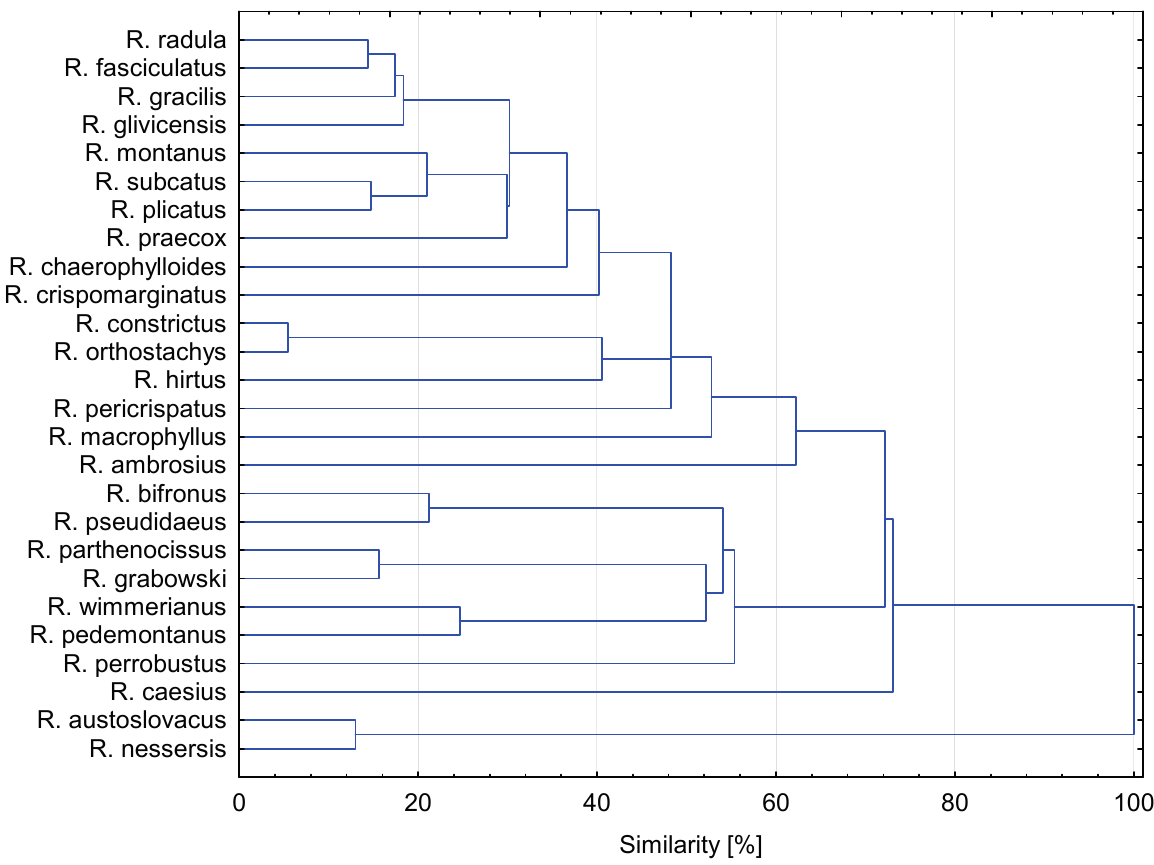
Figure 3. Hierarchical cluster analysis of wild Rubus species based on group average cluster analysis of the phenolic compounds